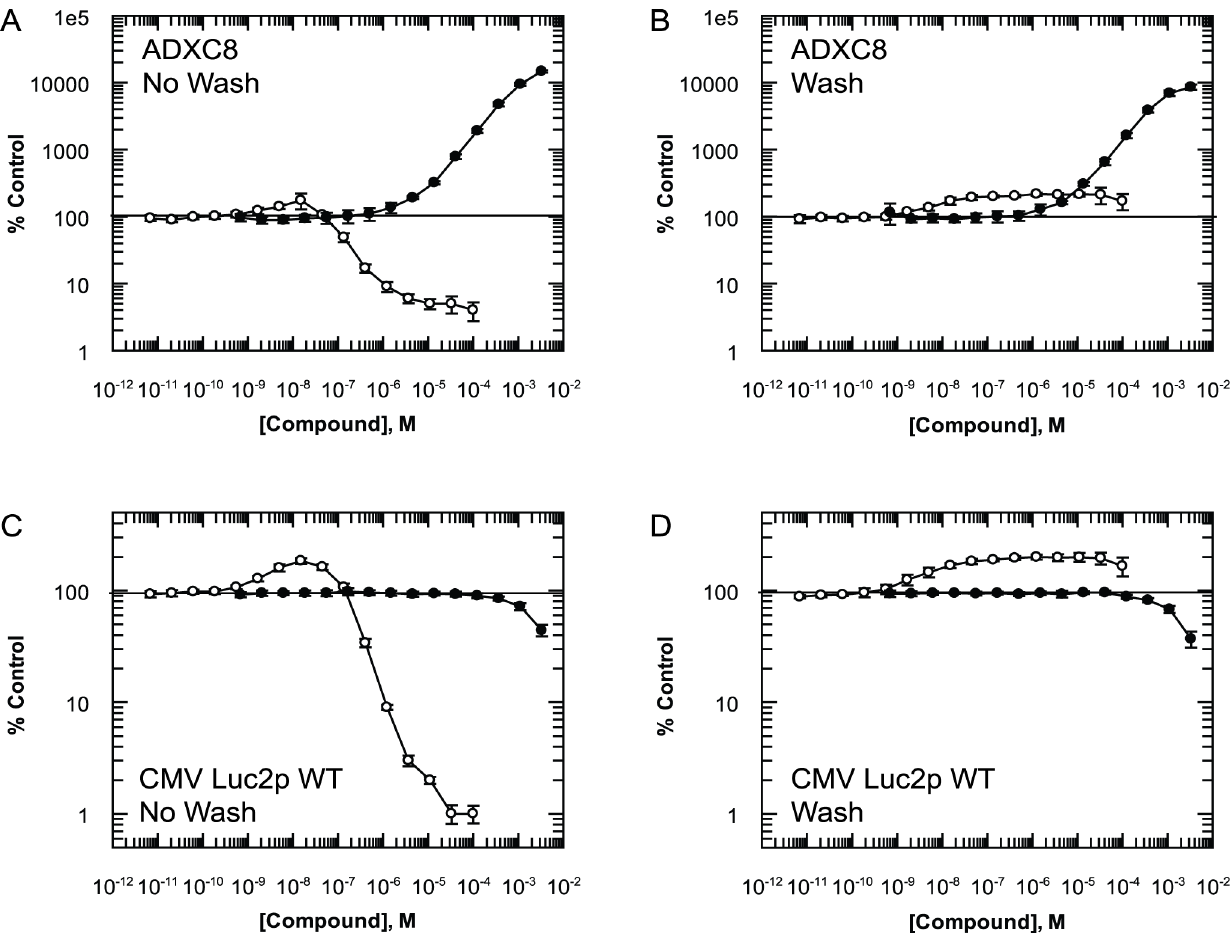
Figure 1. Differing activity of PTC124 and G418 in FLuc reporter cell lines. (A) Stop codon-containing FLuc activity in ADXC8 cells treated for 24 hours with G418 (closed circles) or PTC124 (open circles) which were not washed of compound prior to addition of luciferase detection buffer. (B) FLuc activity in ADXC8 cells in which compound was washed off prior to addition of detection buffer. Both compounds were also tested under the same conditions in WT-FLuc cells using the same (C) no wash and, (D) wash protocol. All data points represent mean 6 standard deviation (n=5).